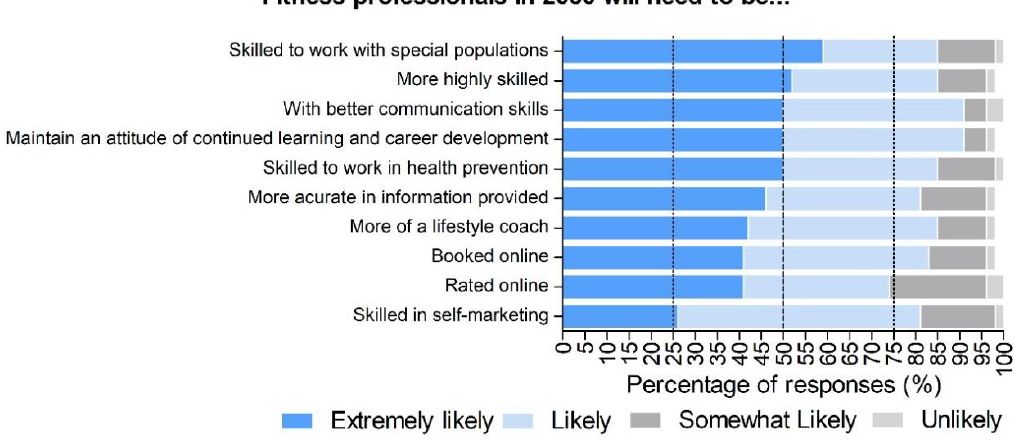
Figure 3. Levels of likeliness rated in percentages (%) by the experts ( n = 50) about the required skills/characteristics of fitness professionals by 2030. In dark blue, extremely likely. In light blue, likely. In black grey, somewhat likely. In light grey, unlikely.